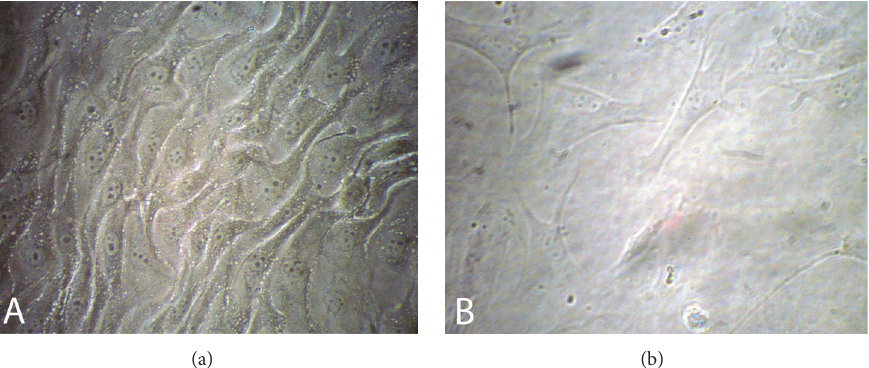
Figure 2: Fibroblast-like morphology of caprine endometrial mesenchymal stromal stem cells in (a) anestrous and (b) breeding stages (magnification: × 200).